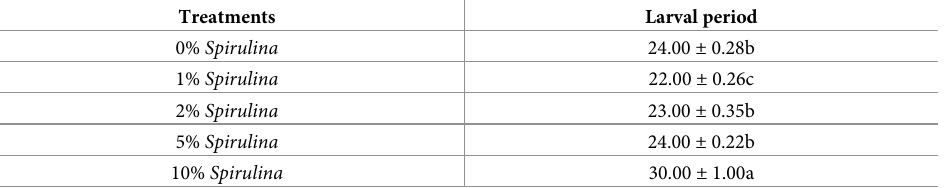
Means followed by the same letters do not differ significantly ( P <